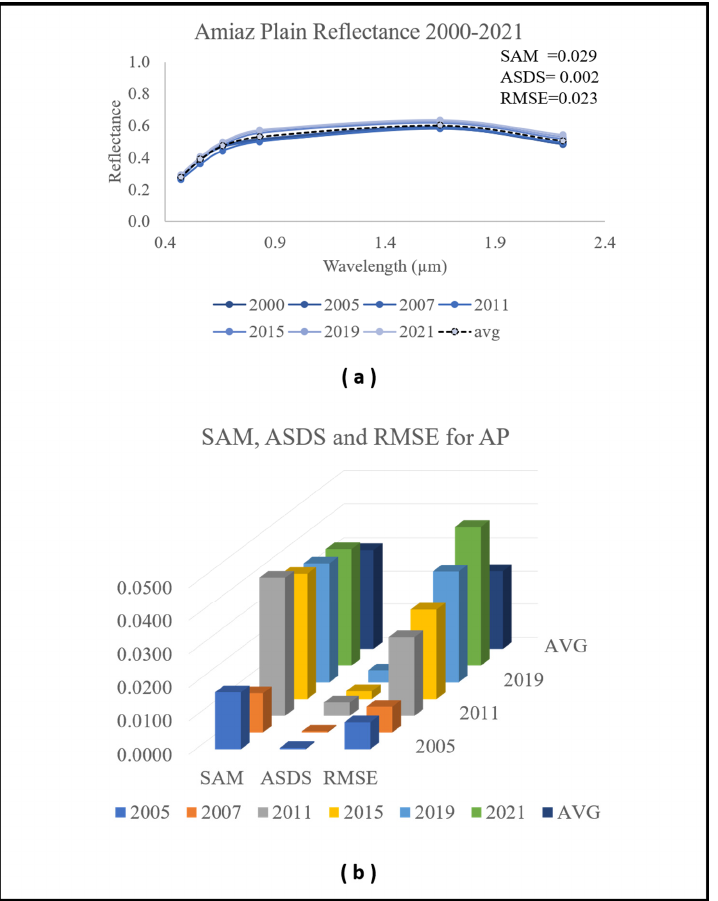
Figure 5. Examination of spectral change in AP. ( a ) Mean Landsat reflectance signal for each year (2000–2021). ( b ) SAM, ASDS, and RMSE for each year against the year 2000 (t0).